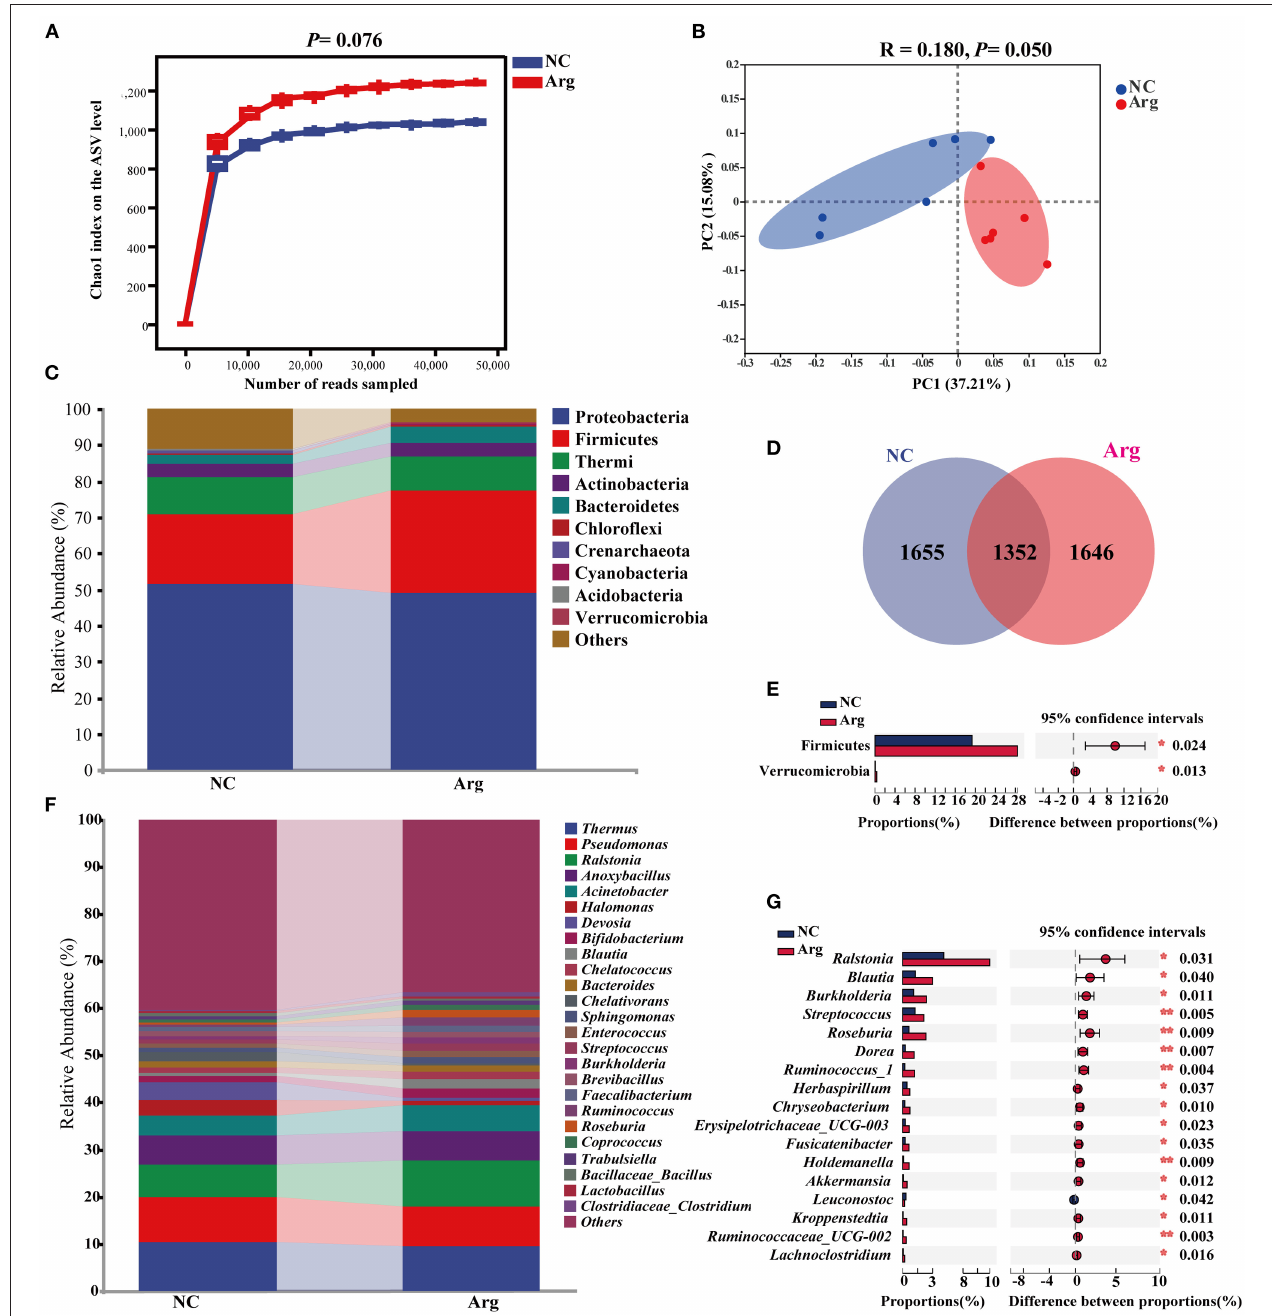
FIGURE 4 | Effects of in ovo feeding of L -arginine on composition and diversity analysis of intestinal microbiota from chick embryos at the age of embryos 21. (A) Chao 1 index on ASVs level; (B) Principal coordinate analysis (PCoA) based on weighted unifrac distance; (D) A Venn diagram based on ASVs level; (C,F) The composition of intestinal microbiota at phylum and genus level, respectively; (E,G) differential species identified at phylum and genus level, respectively; NC, non-injected control group; Arg, injected with 7mg L -arginine